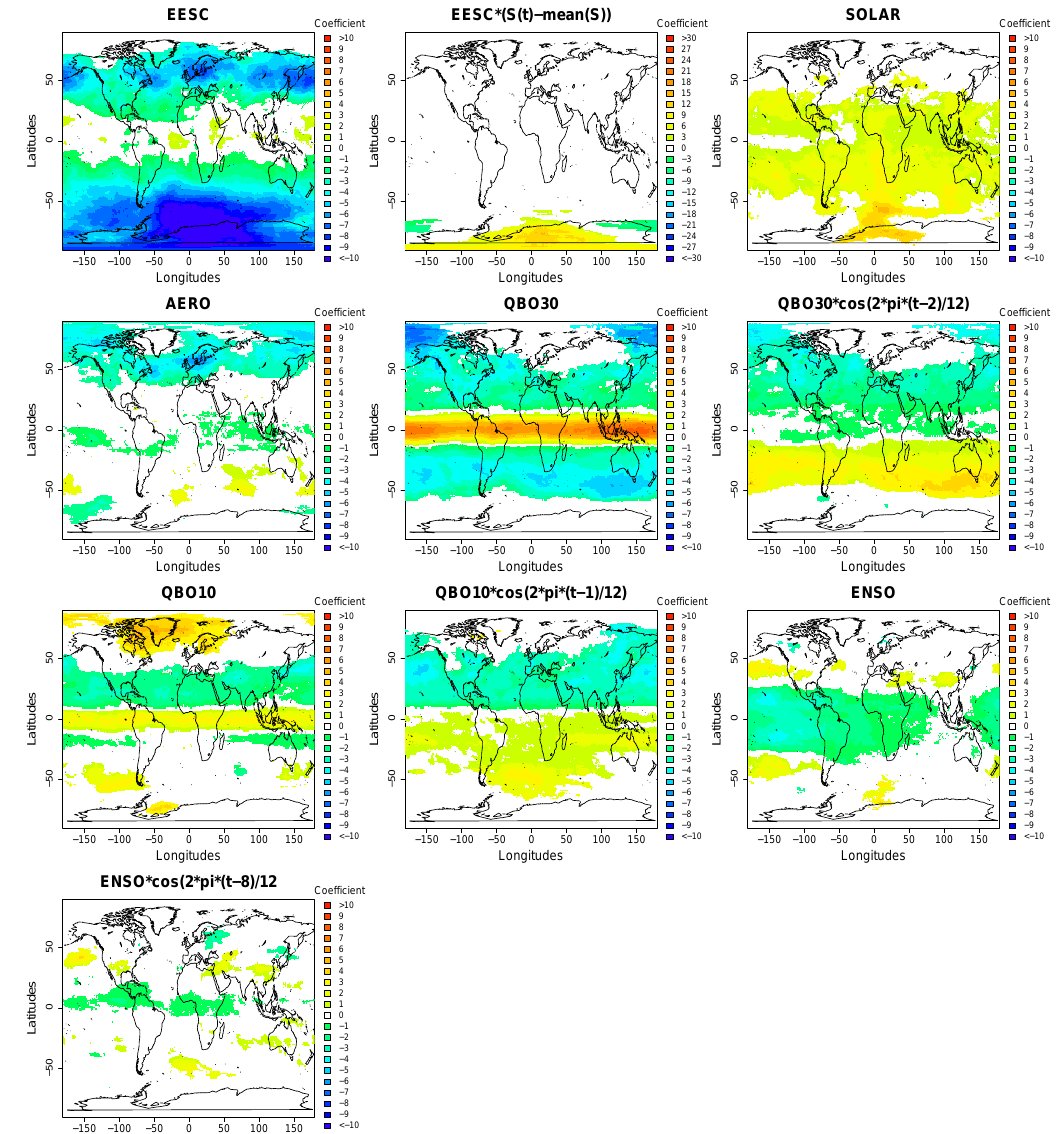
Figure 6. Regression coefficient estimates of nonseasonal variables for the STAT model on a 1 × 1.5 ◦ grid. White regions indicate nonsignif- icant regression estimates at the 99% confidence level. QBO10 and QBO30 represent the QBO index at 10 and at 30hPa, respectively. The coefficients are in DU per unit change of corresponding normalized explanatory variable. Note the different color bar range for the alternative EESC variable (a range of − 30 to 30 against − 10 to 10 for the other